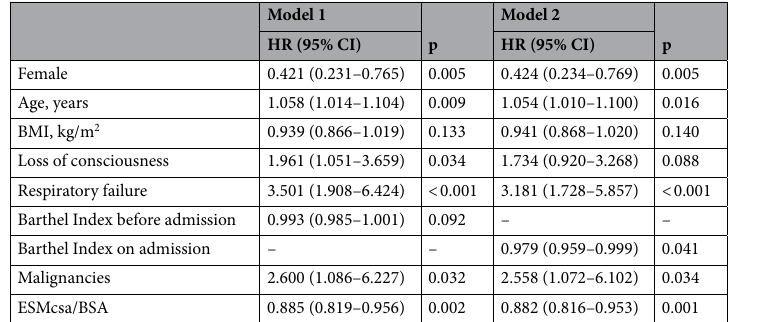
Table 5. Multivariate Cox proportional hazards analyses of 30-day in-hospital mortality. Data are presented as the number (%) or mean ± SD. BMI body mass index, BSA body surface area, CI confidence interval, ESM erector spinae muscle, ESMcsa cross-sectional area of ESM, HR hazard ratio, SD standard